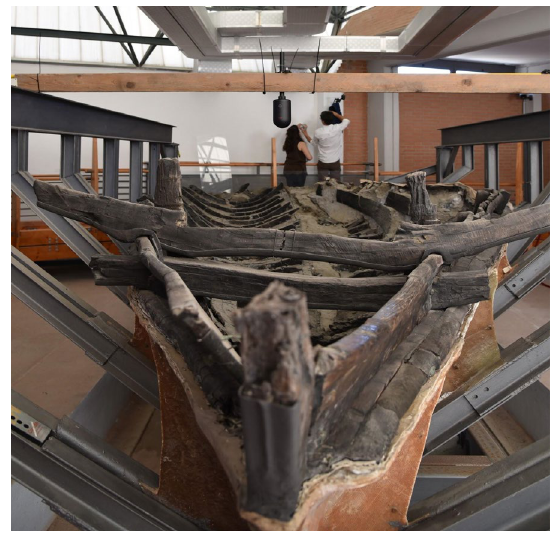
Figure 6. The laser scanner BLK360 mounted, with the help of wooden ribs, on a pole above the